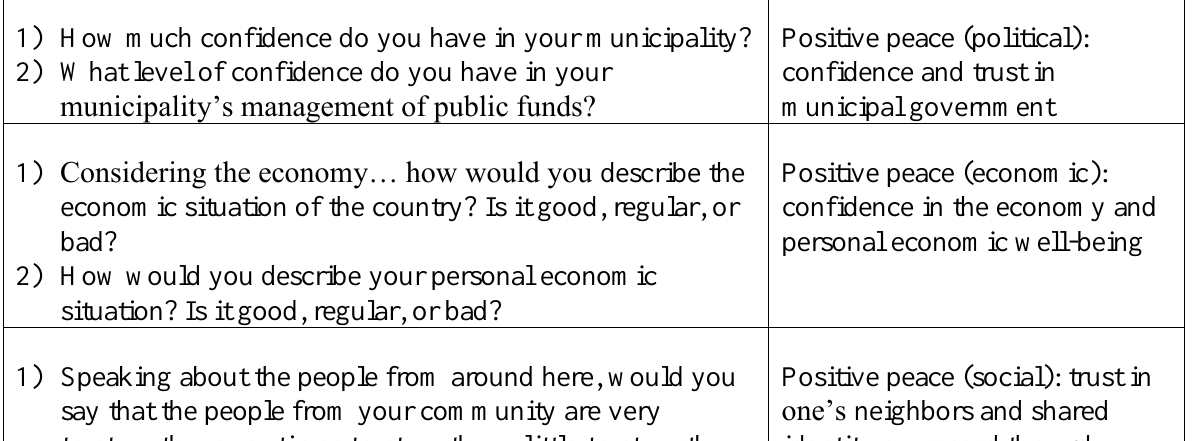
Table 1 Key Concept Measures and Operationalization 2008 AmericasBarometer